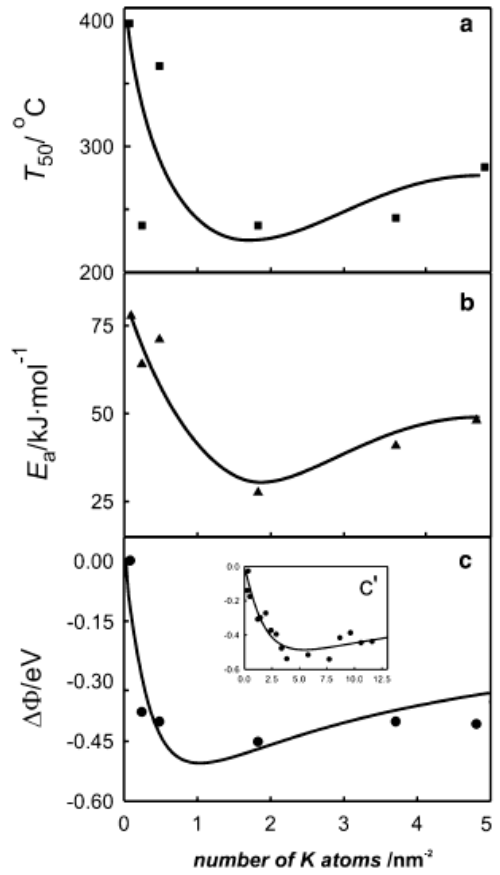
Figure 9. ( a ) The half-conversion temperature of N 2 O (T 50 ), ( b ) apparent activation energy (E a ) and ( c ) work function changes ( ΔΦ ) as a function of potassium loading ( Θ Κ ) introduced from K 2 CO 3 and (c insert) KOH precursor. Reproduced with permission from Reference [179]. Copyright © 2008, Springer